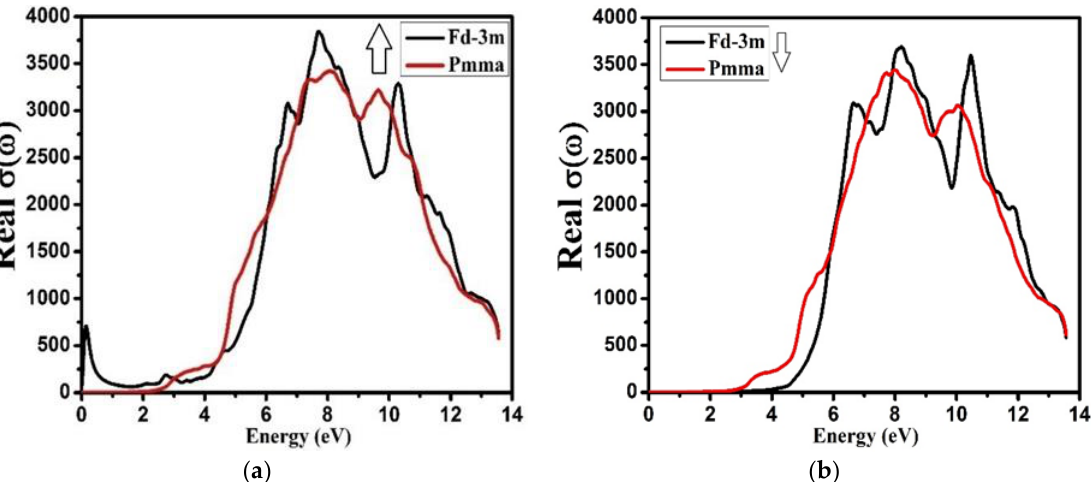
Figure 13. Calculated real optical conductivity σ (ω) for Nd 2 Zr 2 O 7 ((black color for Fd-3m) and (red color for Pmma)) using GGA+U. ( a ) The spin-up direction ( ↑ ) and ( b ) spin-down ( ↓ ) direction.